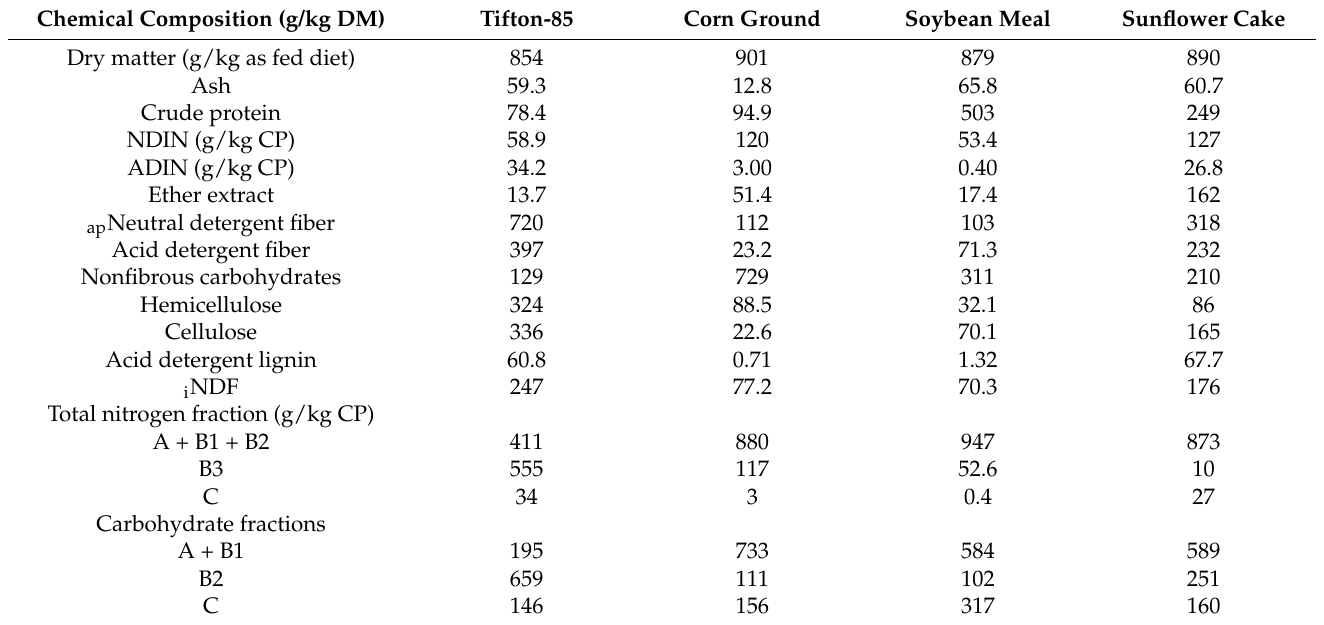
Table 1. Chemical composition of the ingredients used in the experimental diets.